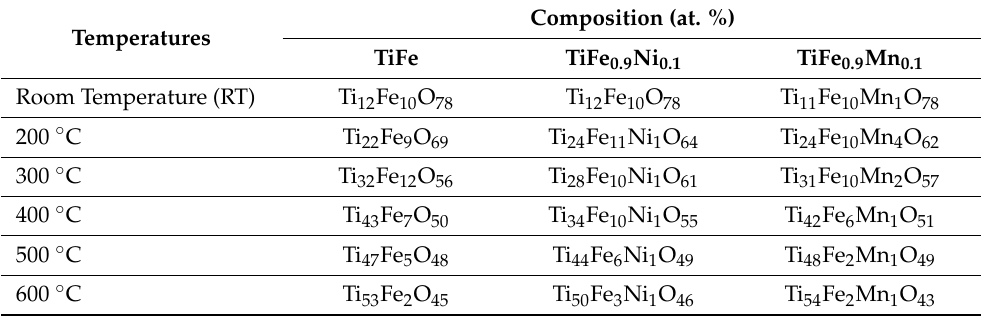
Table 1. The Ni 0.1 and TiFe 0.9 Mn 0.1 alloys during in situ heating X-ray photoelectron spectroscopy